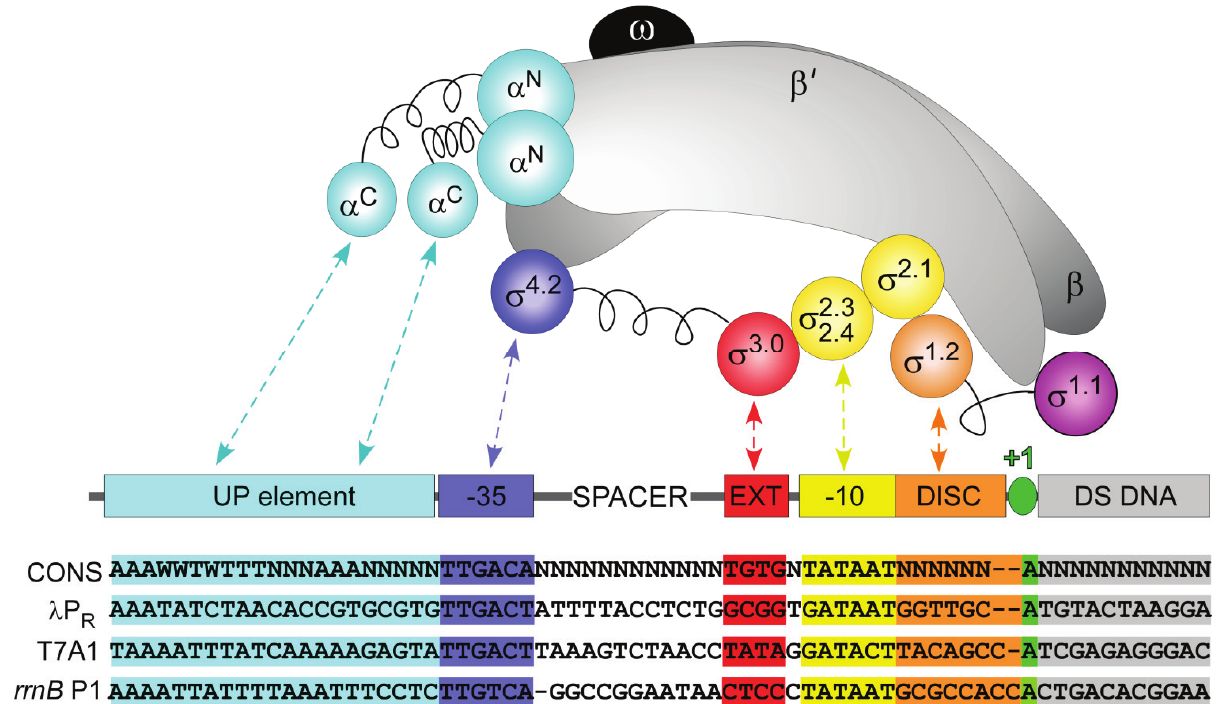
Figure 1. Sequence-specific interactions between (cid:3) 70 RNAP and regions of the promoter. Schematic representations of the subunits of RNAP core, (cid:3) 70 , and promoter DNA. RNAP: (cid:4) 2 : cyan; (cid:5) and (cid:5)': gray; (cid:6): black. (cid:3) regions: as shown. Promoter: UP element: cyan; (cid:2)35 element: blue; extended (cid:2)10: red; (cid:2)10 element: yellow; discriminator: orange; transcription start site: green; DNA downstream of the transcription start site: gray. Linker regions in (cid:4) and (cid:3) subunits are shown as springs. Nontemplate strand sequences of a “consensus” and (cid:7)P R , T7A1 and rrn B P1 promoters are shown below; missing bases are indicated by